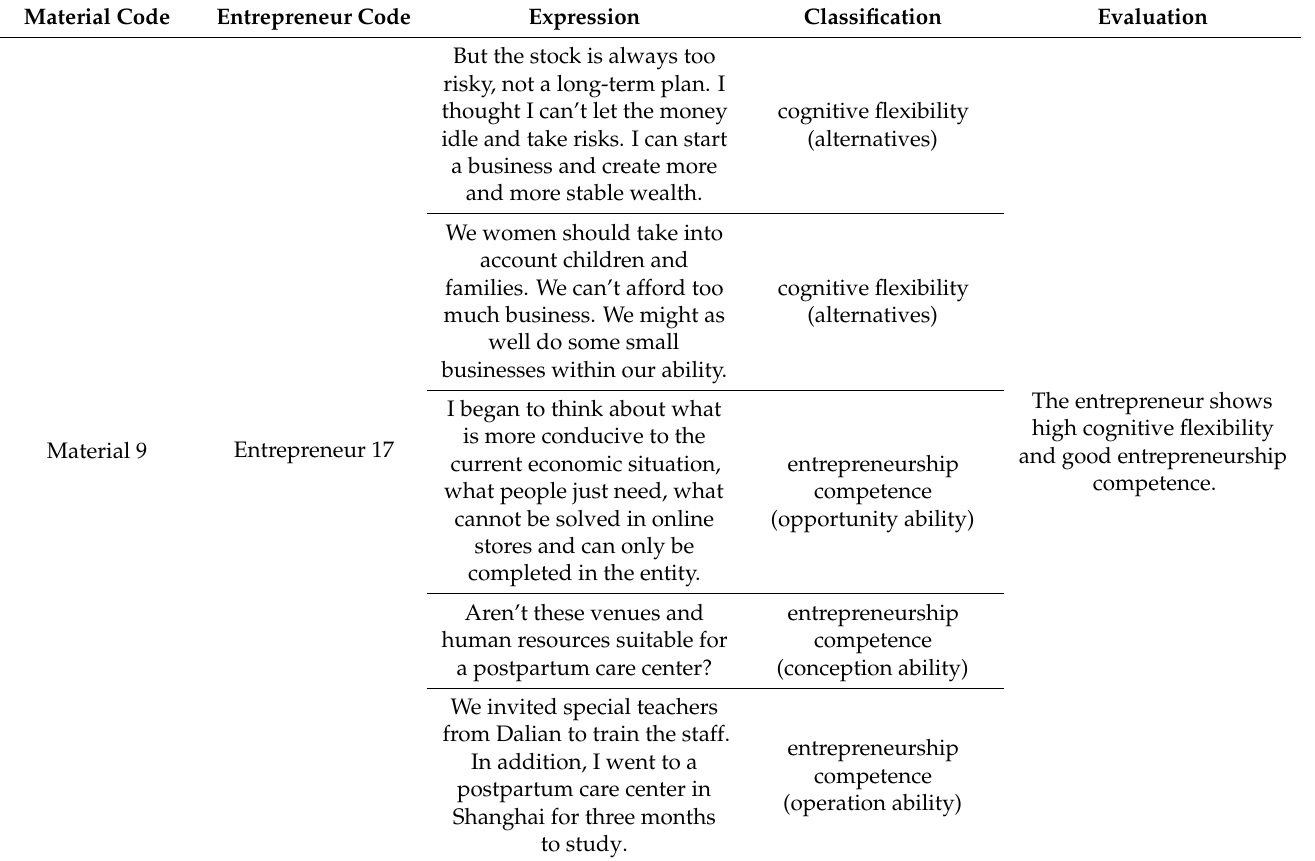
Table 3. Interview material distilling